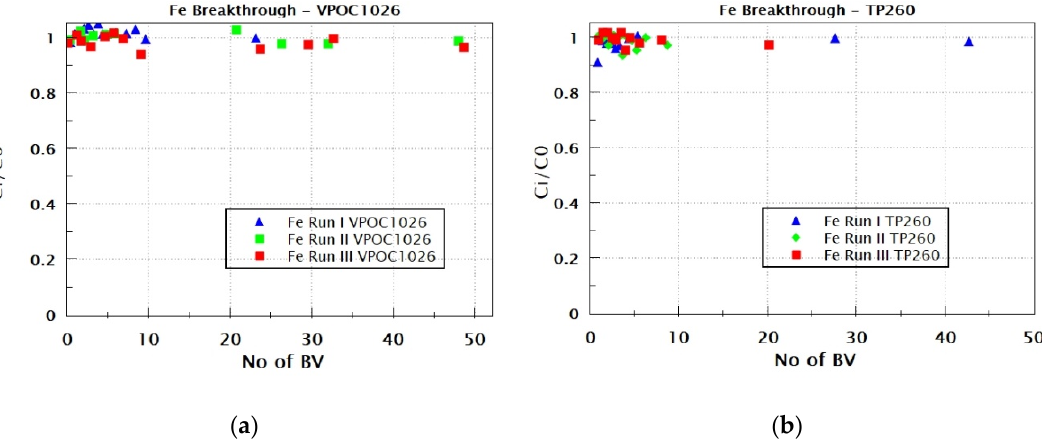
Figure 6. Chemical analysis results of Fe for VP OC 1026 ( a ) and TP 260 ( b ) resin throughout adsorption experiments.